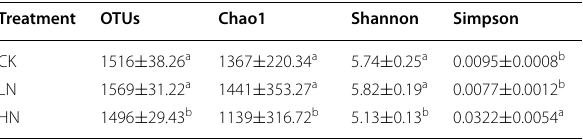
Table 2 α diversity of the soil bacterial community under different nitrogen deposition treatments Treatment OTUs Chao1